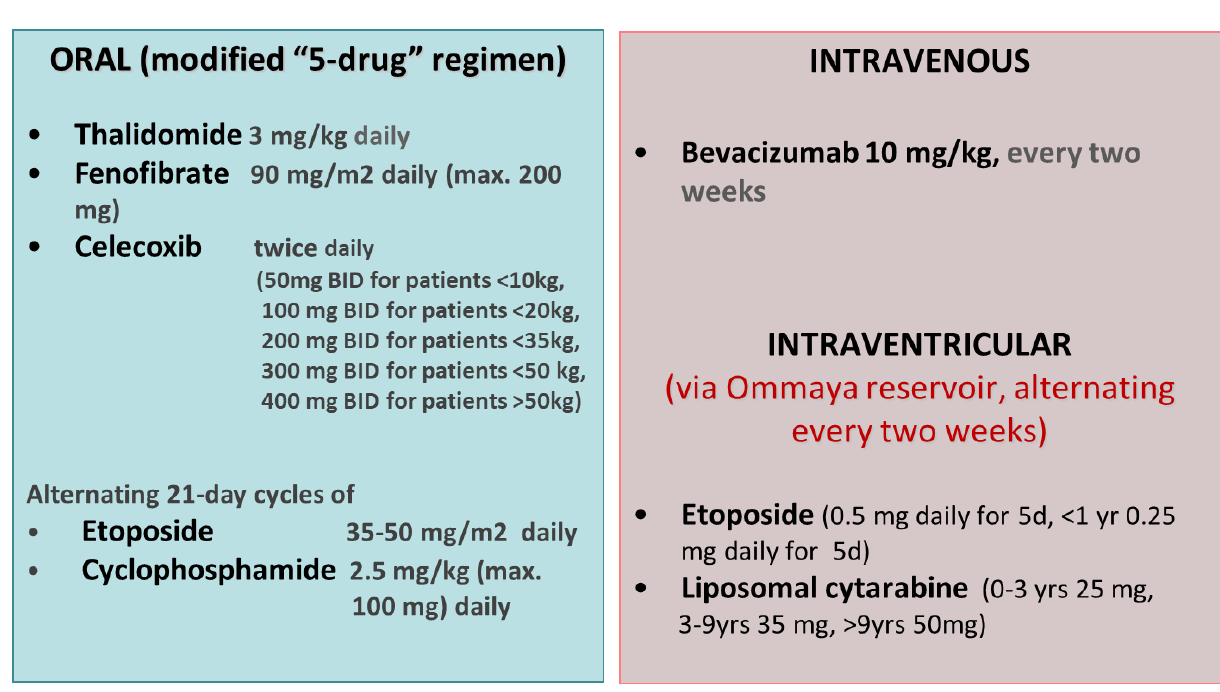
Figure 1. Drugs, dosing, and schedule of MEMMAT-based therapy.